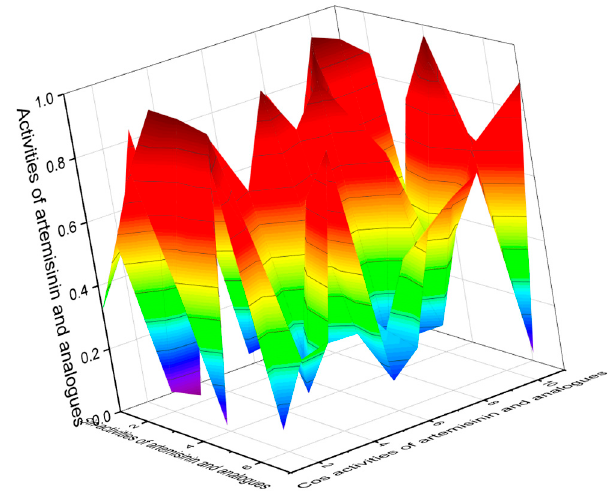
Figure 12. The 3D graph shows the predicted and calculated pharmacological activities of artemis- inin ( 86 ) and its analogs, such as 12 α -OH-artemisinin ( 87 ), 12 β -OH- artemisinin ( 88 ), artemether ( 89 ), arteether ( 90 ), artelinate ( 91 ), and artesunic acid ( 92 ). According to the PASS data, artemisinin and its analogs ( 86–92 ) show selective activity against obligate intracellular protozoan parasites belonging to the genera Plasmodium, Toxoplasma, Leishmania , and Coccidia , which is the main pharmacological activity with a confidence level of more than 90%. In addition, all these endoperoxides show antifungal activity against the opportunistic pathogenic yeasts Candida and Cryptococcus , as well as anticancer activity for some compounds; the confidence level exceeds 90 percent.